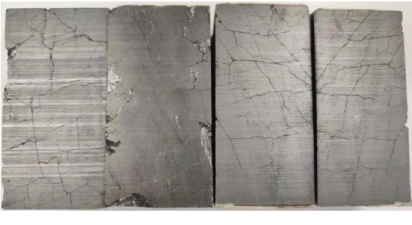
Figure 1: Sample